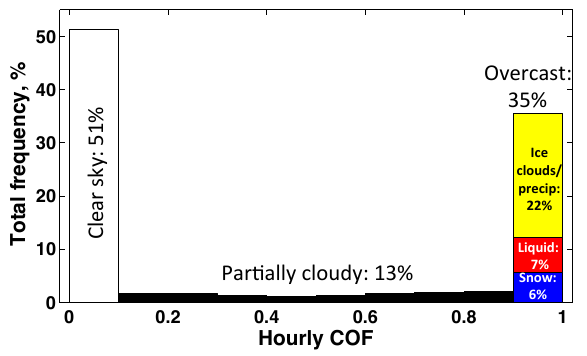
Figure 7. Total frequency relative to the measurement period (%) of hourly mean cloud occurrence frequency (COF; unitless fraction from 0 to 1) for all clouds and precipitation. The column corre- sponding to COF > 0 . 9 shows also total frequency of liquid clouds (red), snowfall (blue), and ice clouds/precipitation not detected by MRR (yellow). Based on the measurement periods during 2010– 2013 indicated in Table 1 (14 months mainly in summer–beginning of